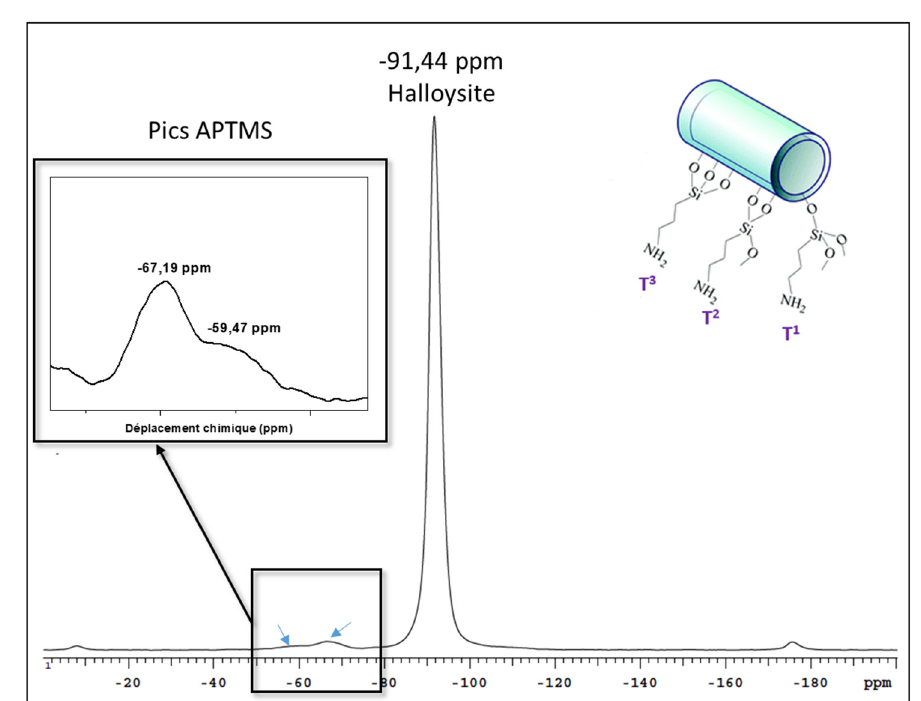
Figure 3. 29 Si NMR spectrum of HNT-NH 2.